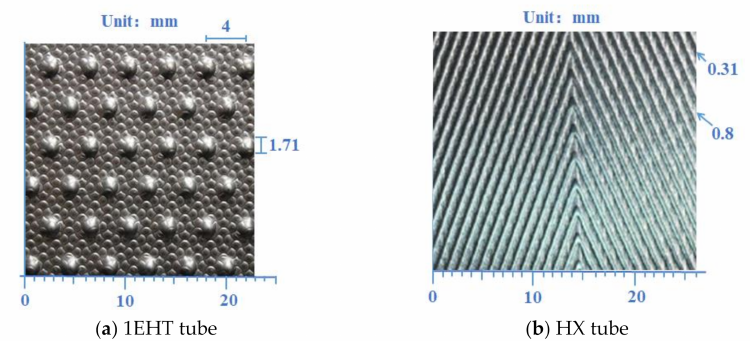
Figure 3. Images of the surface enhancement characters on the enhanced heat transfer surfaces: ( a ) 1EHT; ( b )